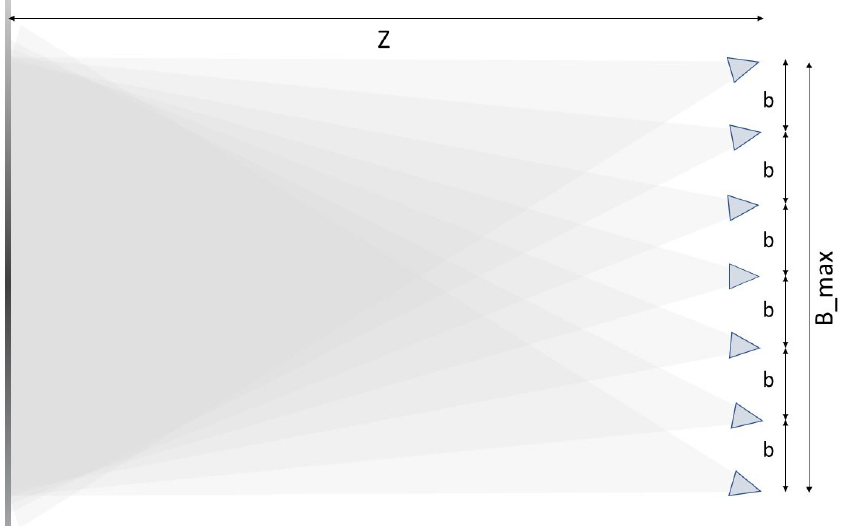
Figure 1. Characteristics of the camera networks used in this study. “B_max” is the distance between the first and the last camera station, “b” is the average value of base length between two consecutive camera stations, and “Z” is the object distance.